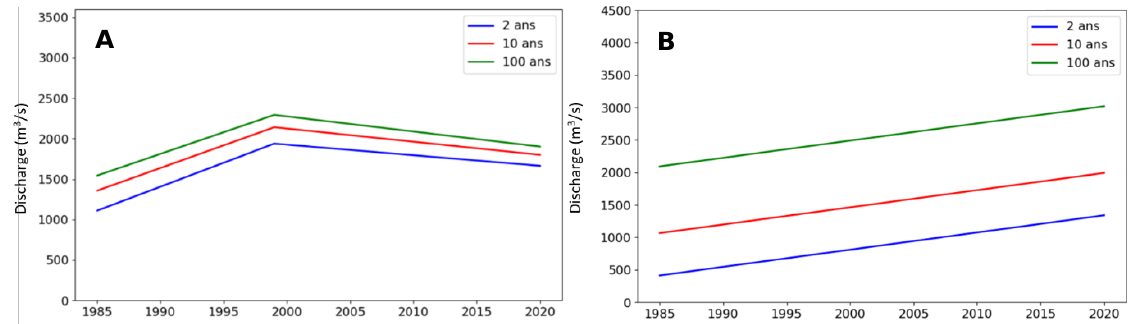
Figure 9. Evolution of return levels for three return periods (2, 10 and 100 years): ( A ) (left) black and ( B ) (right) red floods in the Niamey City.